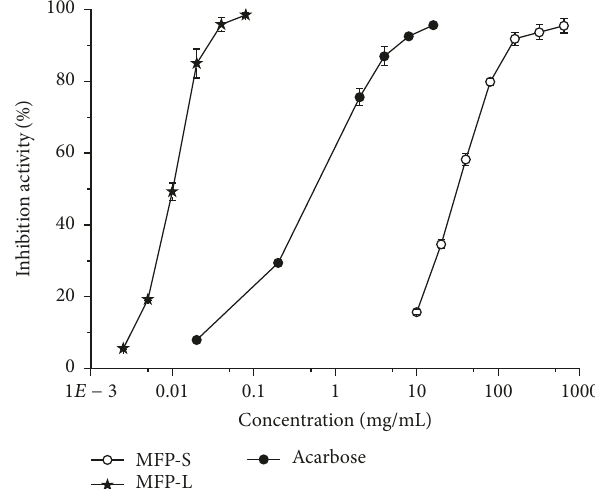
Figure 5: 𝛼 -Glucosidase inhibitory activities of MFP-S and MFP-L with acarbose used as positive